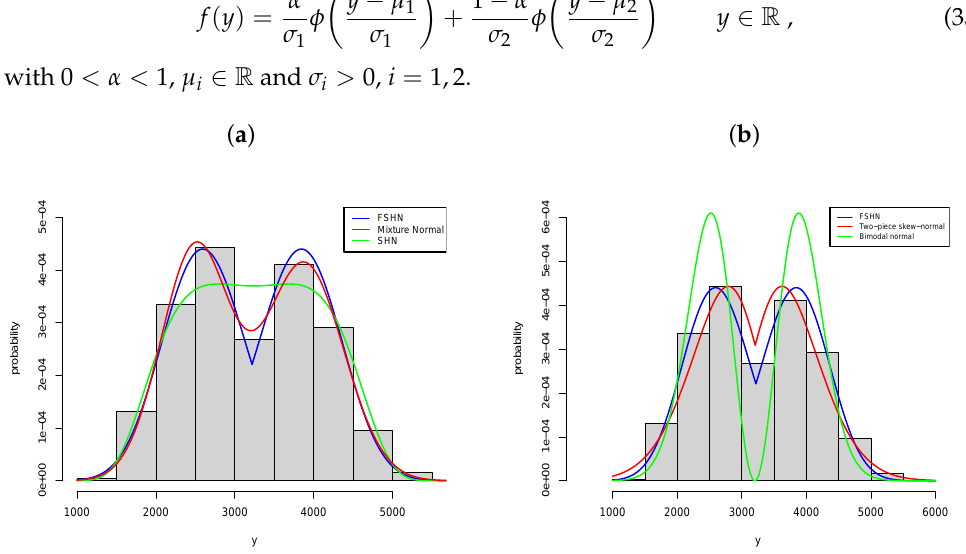
Figure 5. b.weight histogram and fitted bimodal models: ( a ) FSHN (blue), mixture normal (red) and SHN (green); and ( b ) FSHN (blue), two-piece skew normal (red) and bimodal normal (green).